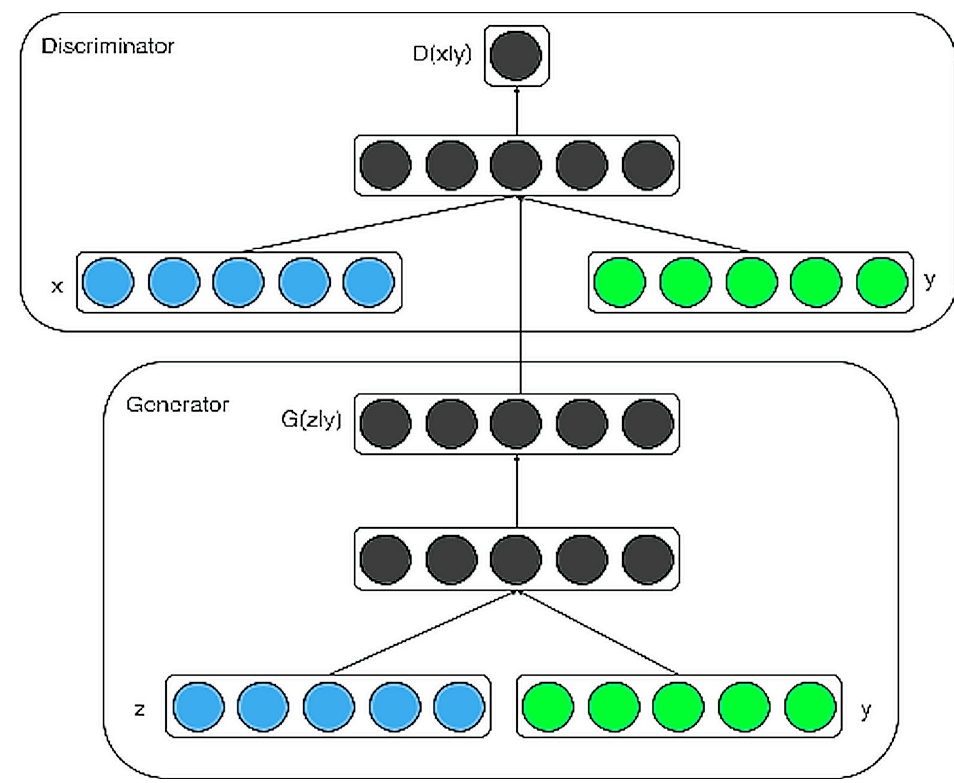
Figure 3. Architecture of the Conditional adversarial net.